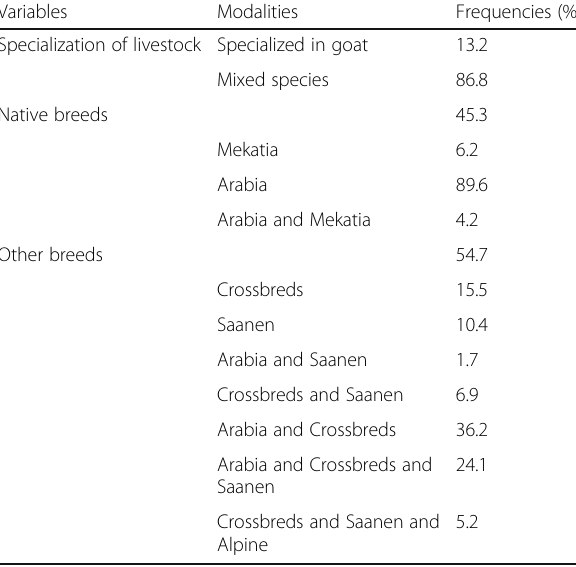
Table 2 Goat herds composition in Laghouat region